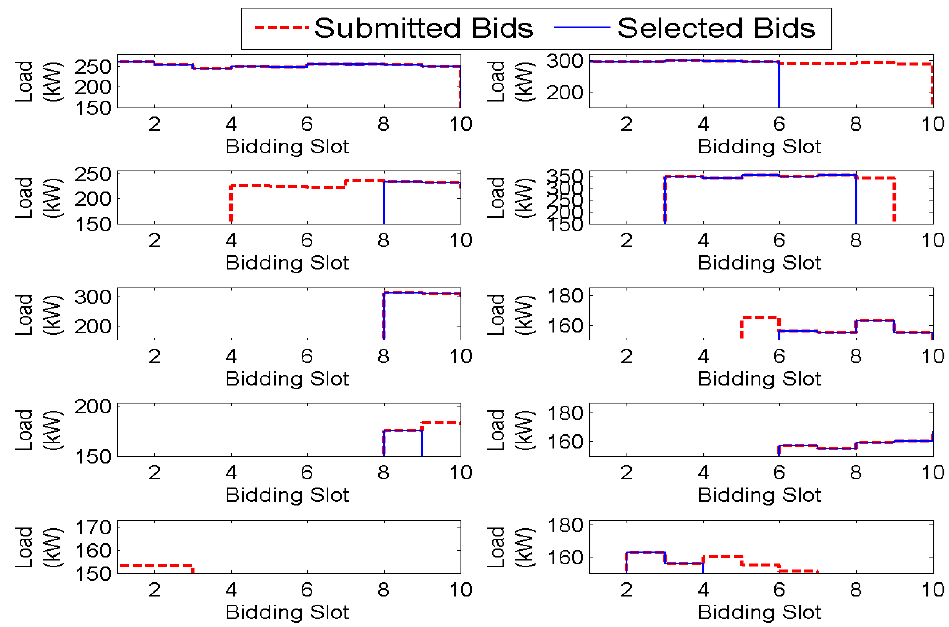
Figure 4. The input load curtailment bids submitted by ten randomly selected customers and the output purchase status computed by the proposed method.